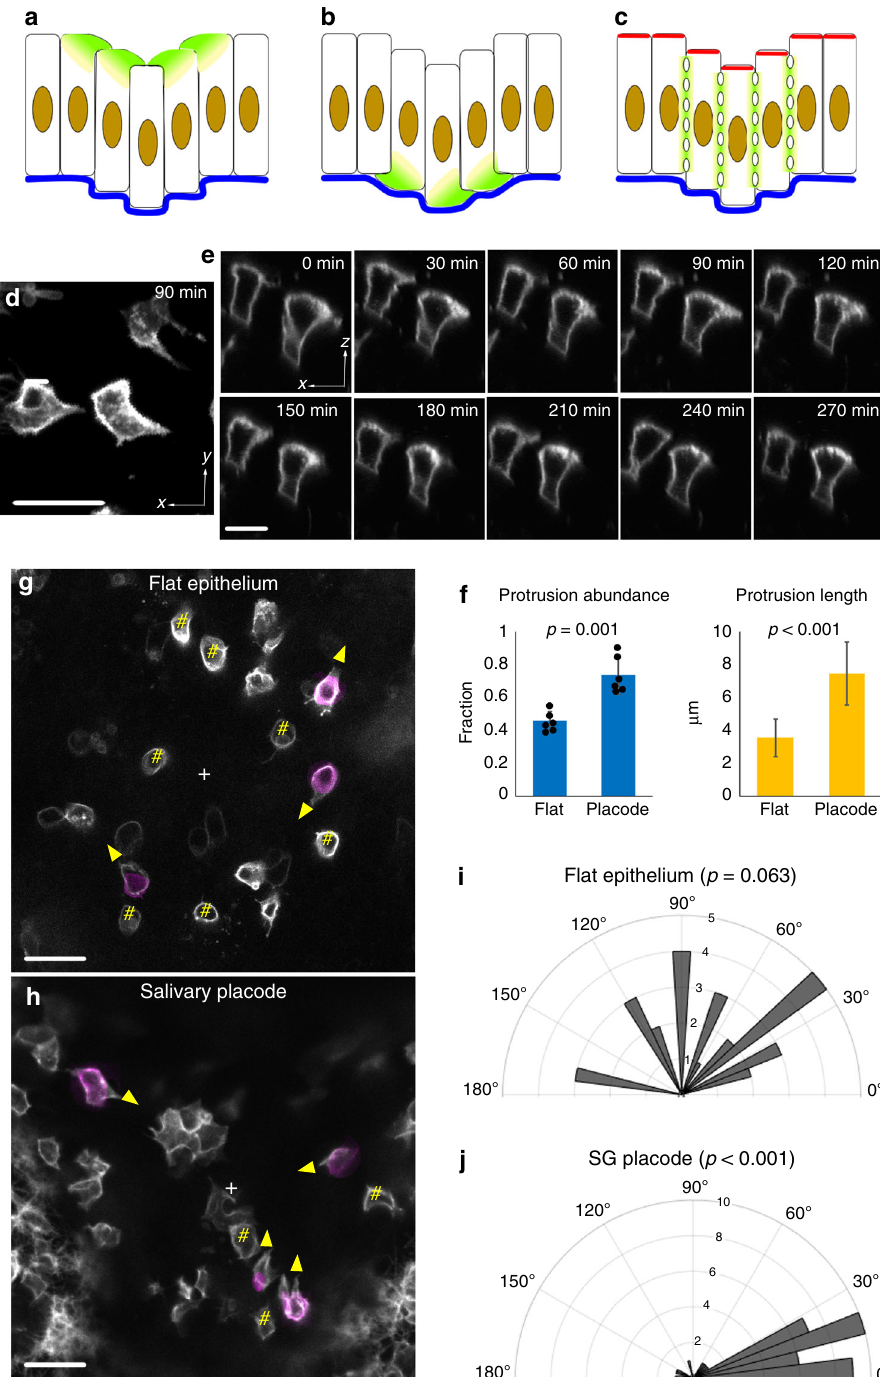
Fig. 3 Centripetal apical protrusions are associated with VT. a – c Schematics of possible cell behaviour in VT: apical protrusion ( a ), basal protrusion ( b ) and lateral undulation ( c ). d , e , g , h Stills from movies of mosaically labelled epithelia. d Top view of apical protrusions in SG placode from Supplementary Movie 3 (placode centre is to the right). e Side view of apical protrusions from Supplementary Movie 2 (placode centre is to the right). Successive frames show protrusions are dynamic. f Quanti fi cations of the abundance and length of the protrusions. g , h Top view of an area of fl at epithelium ( g ) and SG placode ( h ) to show the orientation of apical protrusions (grayscale cell contours at the apical end extending beyond magenta-coloured cell contour at mid- height, yellow arrowheads show direction). Hash marks (#) indicate non-protrusive cells. “ + ” indicates the centre of the microscope fi eld ( g ) or of the placode ( h ). To avoid cell shape ambiguity, only isolatedly labelled basal cells were analysed. i , j Quanti fi cation of orientation of protrusions (0° indicates protrusion towards fi eld/placode centre). p Values are calculated using the Rayleigh test for circular data (test for non-uniform disribution) and two-tailed unpaired t test for abundance and length data. Sample sizes for f , i and j 3 independent litters, 6 SG placodes, 40 protrusive cells in total, 6 fl at regions and 28 cells in total. Bar graphs are means± SDs. Scale bars: 20 μ m. Source data are provided as a Source Data fi